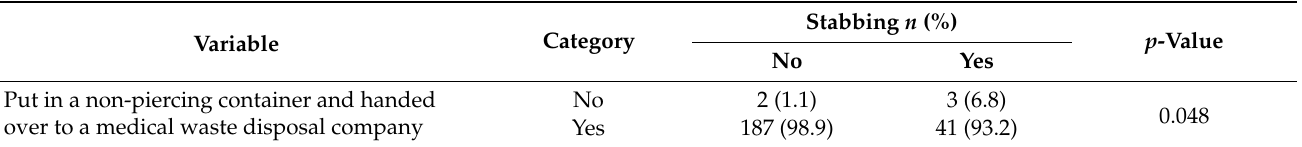
Table 6. Needle stick injury events and sharp waste disposal in tattoo